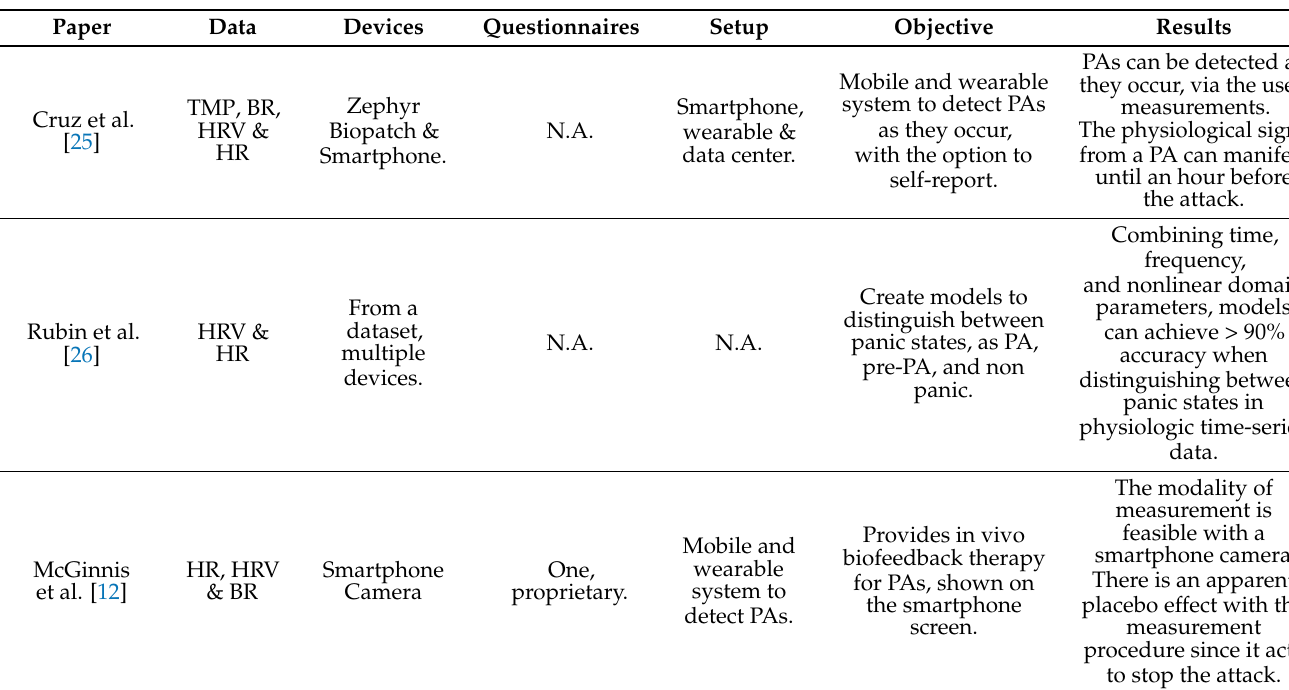
Table 1. An overview of all papers that use wearable devices to perform anxiety-related measure- ments. The first column shows the papers’ authors. The second column lists physiological data. The table foot list the wearable sensors, the questionnaires, and the setup (if any). In the sixth column, the objective is presented, followed by the results of each objective. The abbreviations used in the table can be found at the end of the